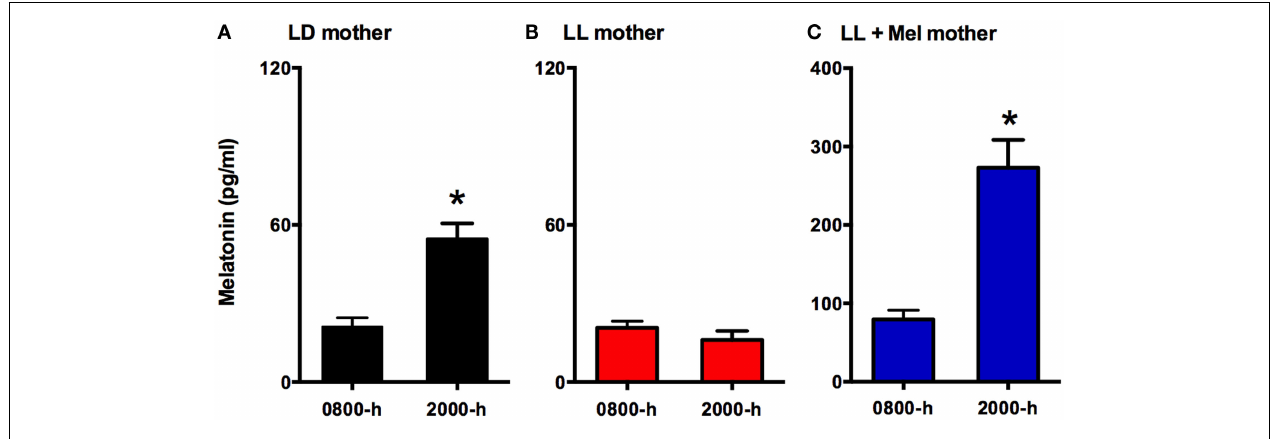
under continuous light from 60% gestation and LL + Mel ewes ( n = 6) (C) were kept in continuous light but received an oral dose of 12mg melatonin at 1700hrs. *Different to 0800h, p < 0.05 (paired t